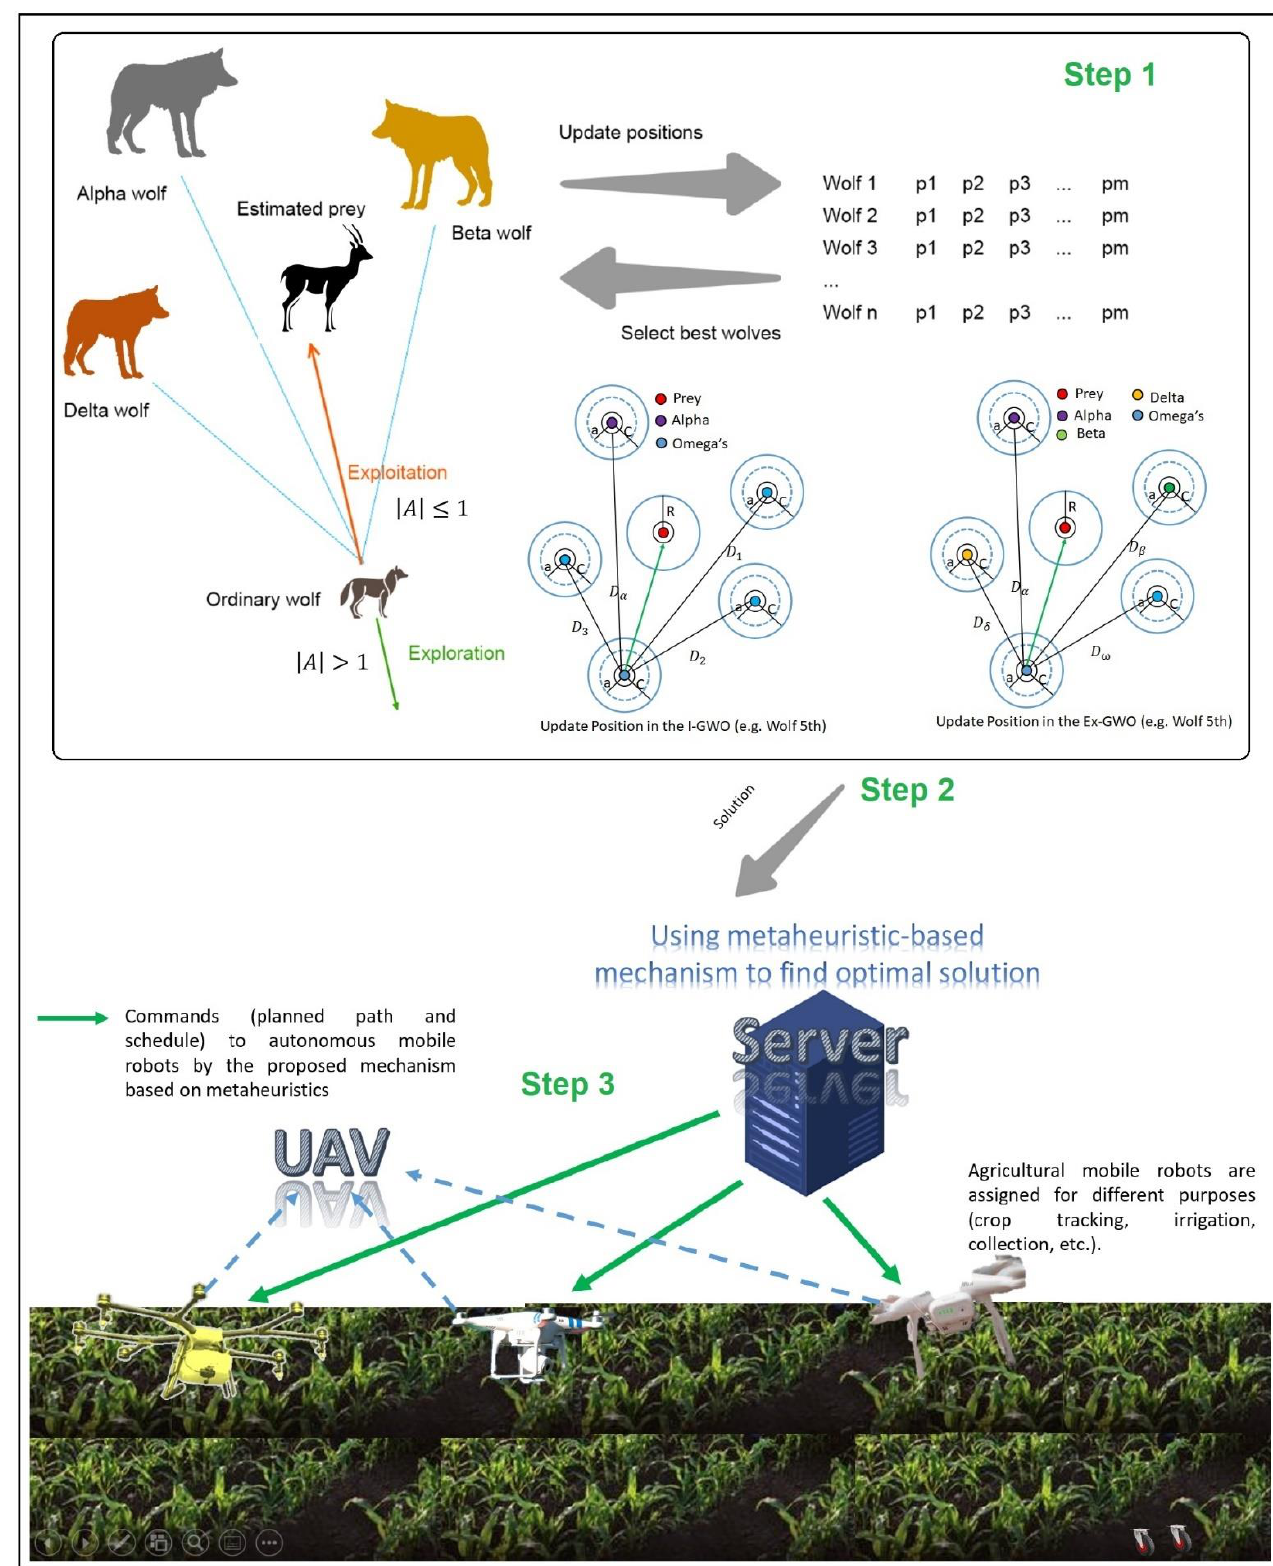
Figure 4. Working mechanism of the proposed method in UAV-based agricultural applications.